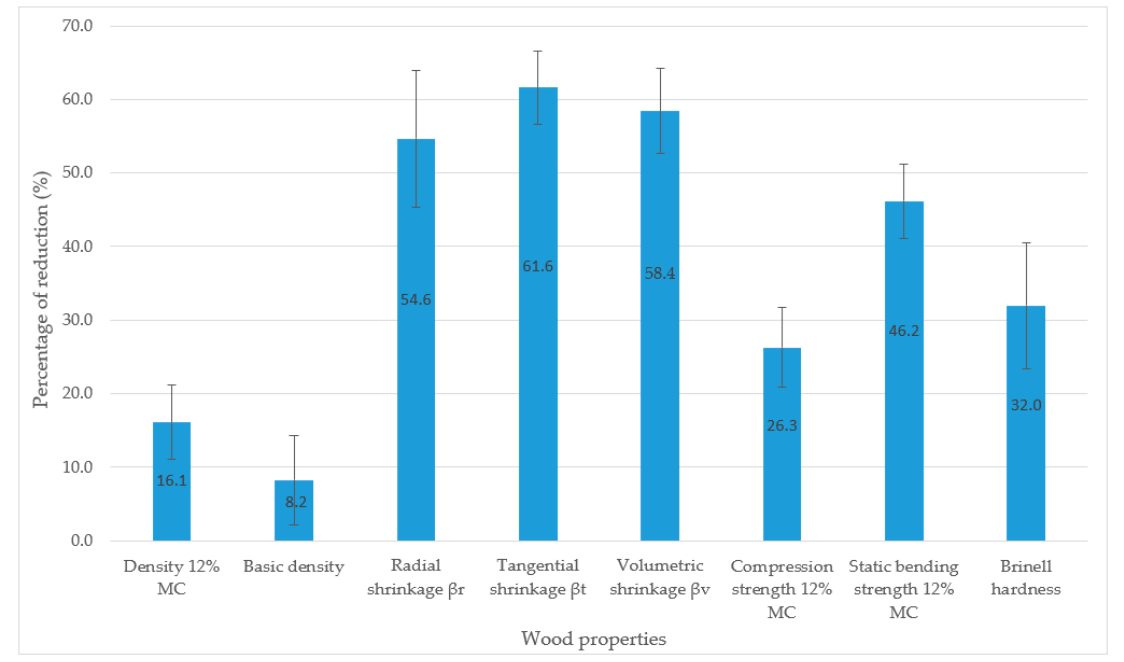
Figure 2. Percentage of variation (reduction) of the mean values, for the heat-treated wood with respect to the normal wood [14,26]. The bars showed the standard deviation.